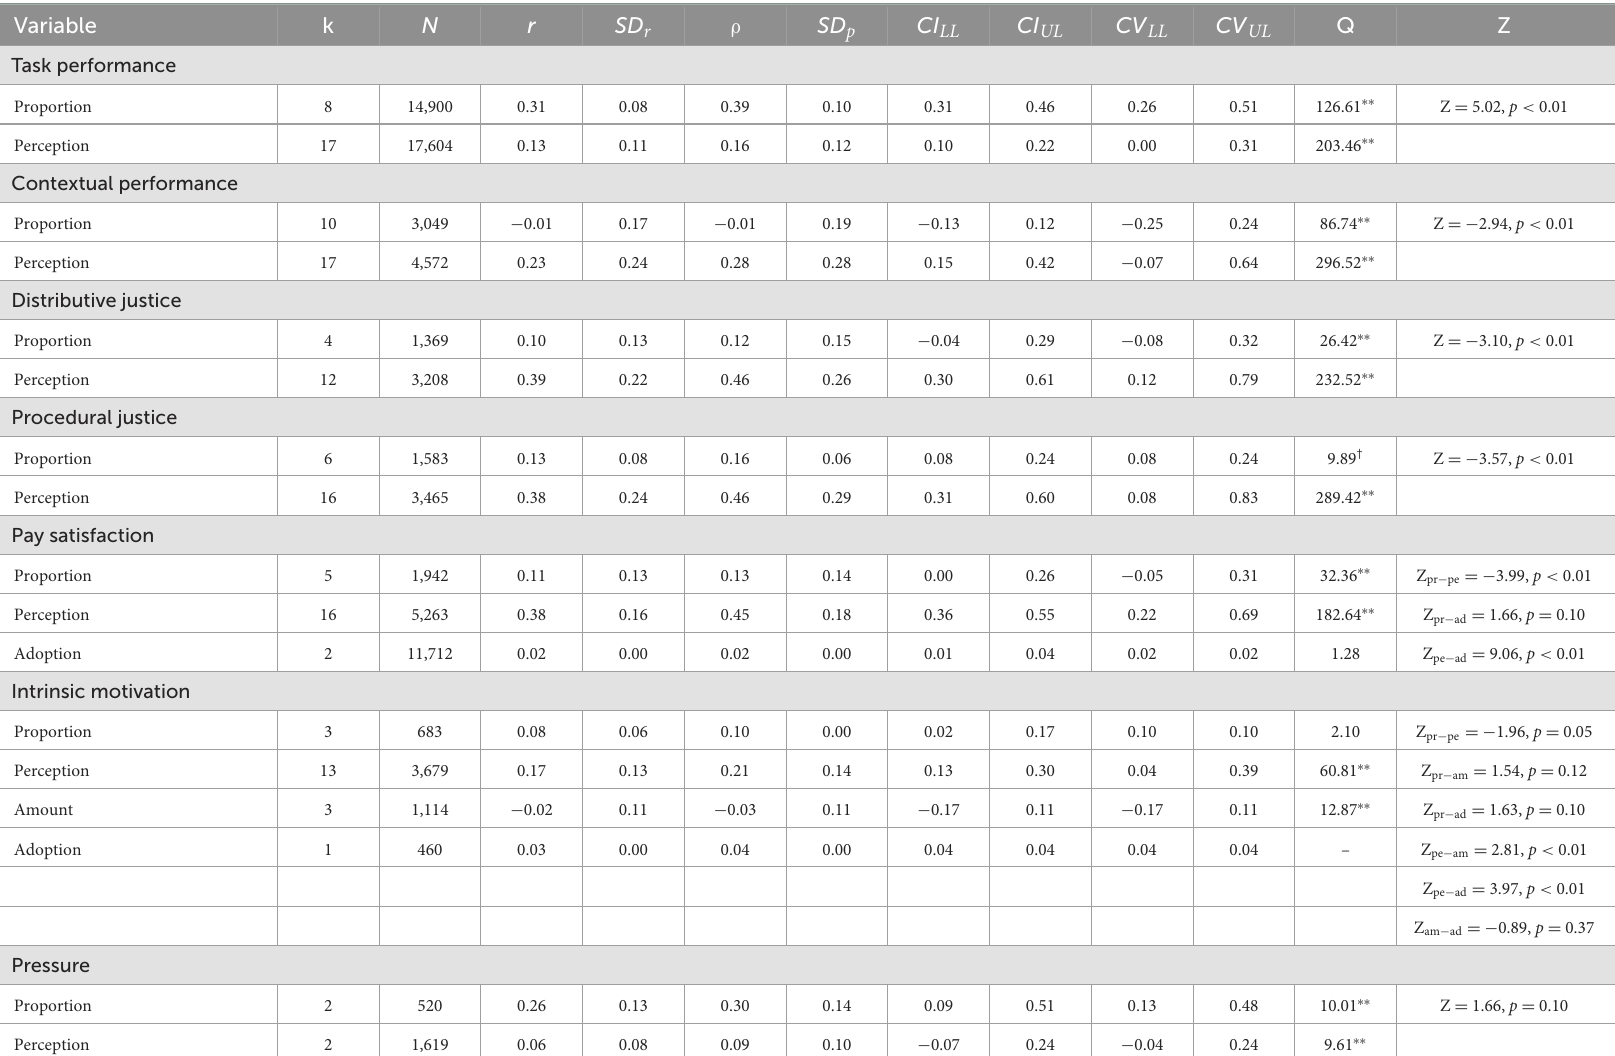
TABLE 6 Moderating effect of PFP operationalization on relationships between PFP and